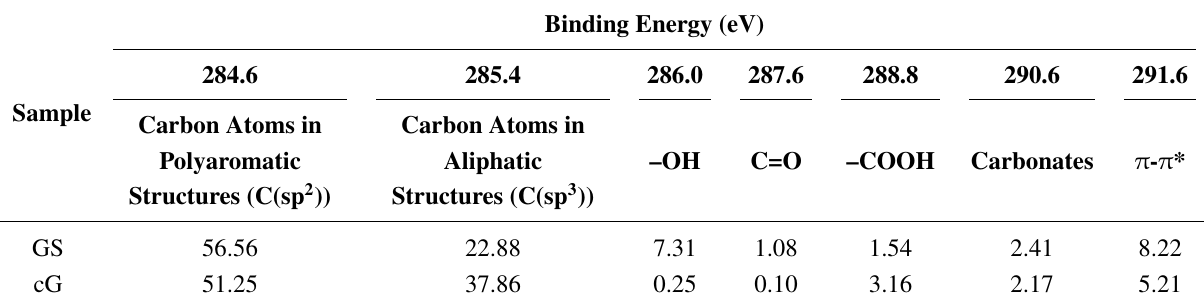
Binding Energy (eV)